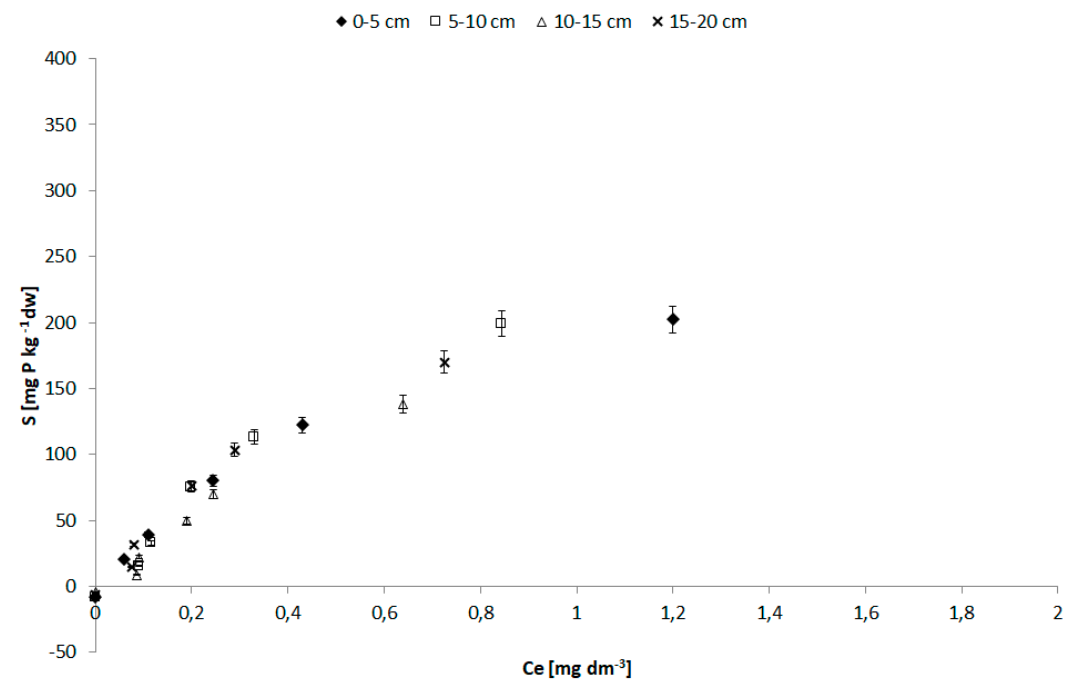
Water 2019 , 11 , x FOR PEER REVIEW Figure 2. The P adsorption isotherms for sediment taken at St. 1. Figure 2. The P adsorption isotherms for sediment taken at St. 1.